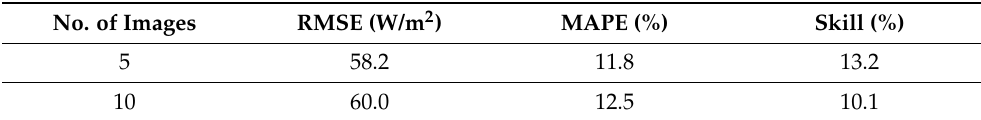
Table 4. The influence of image horizon.